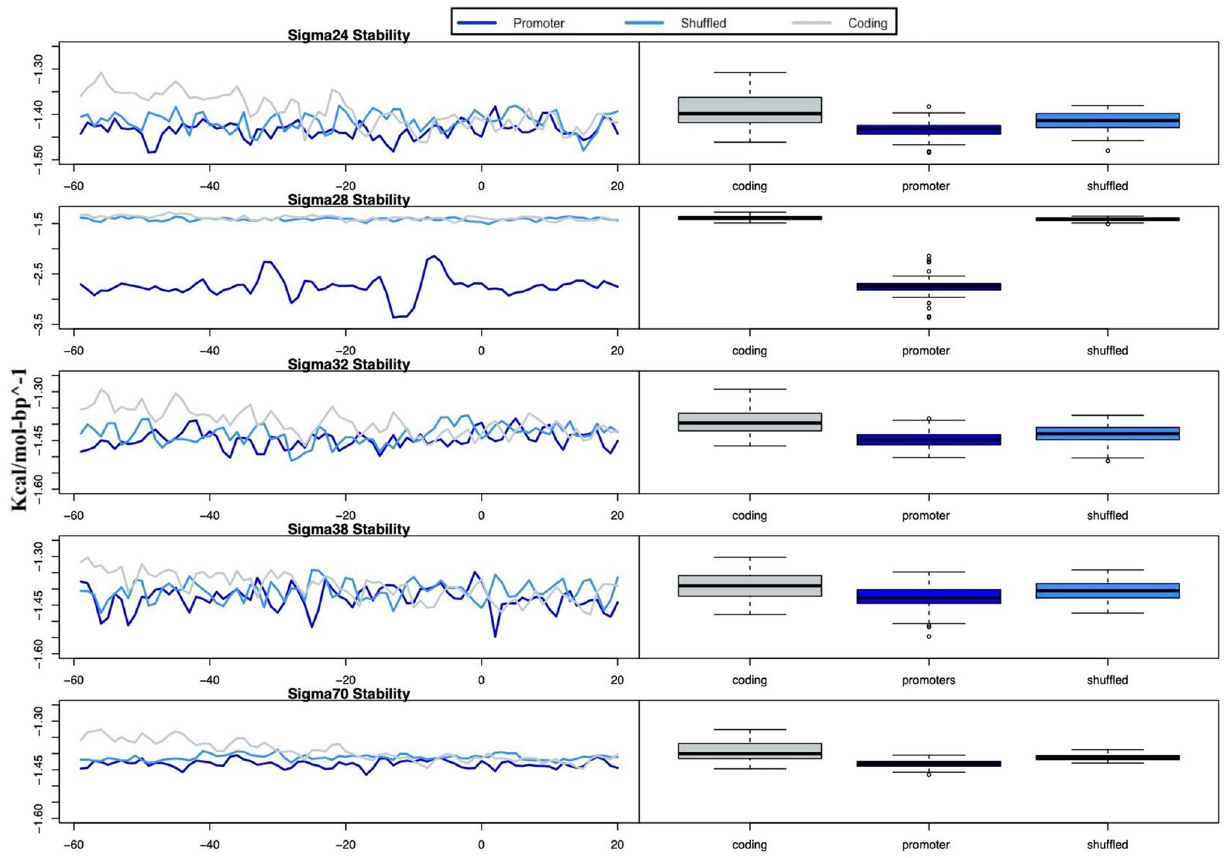
panel represents the boxplots of the profiles of promoter, shuffled, and coding sequences, whose Y-axis is in the same scale as the left